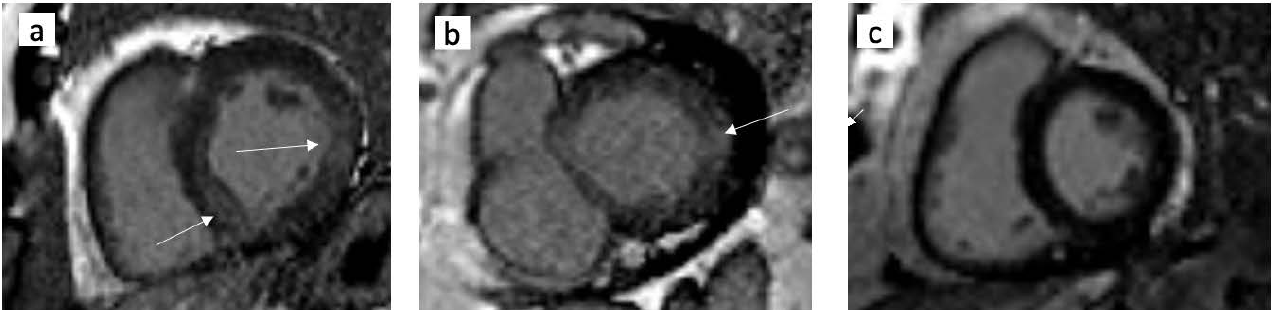
Figure 1. Examples of cardiac MRI with and without LGE: ( a ) a T2DM patient with positive LGE; ( b ) RF patient with positive LGE; ( c ) RF patient without LGE; the white arrows indicate LGE areas in the septum; ( a ) left lateral LV wall ( a , b